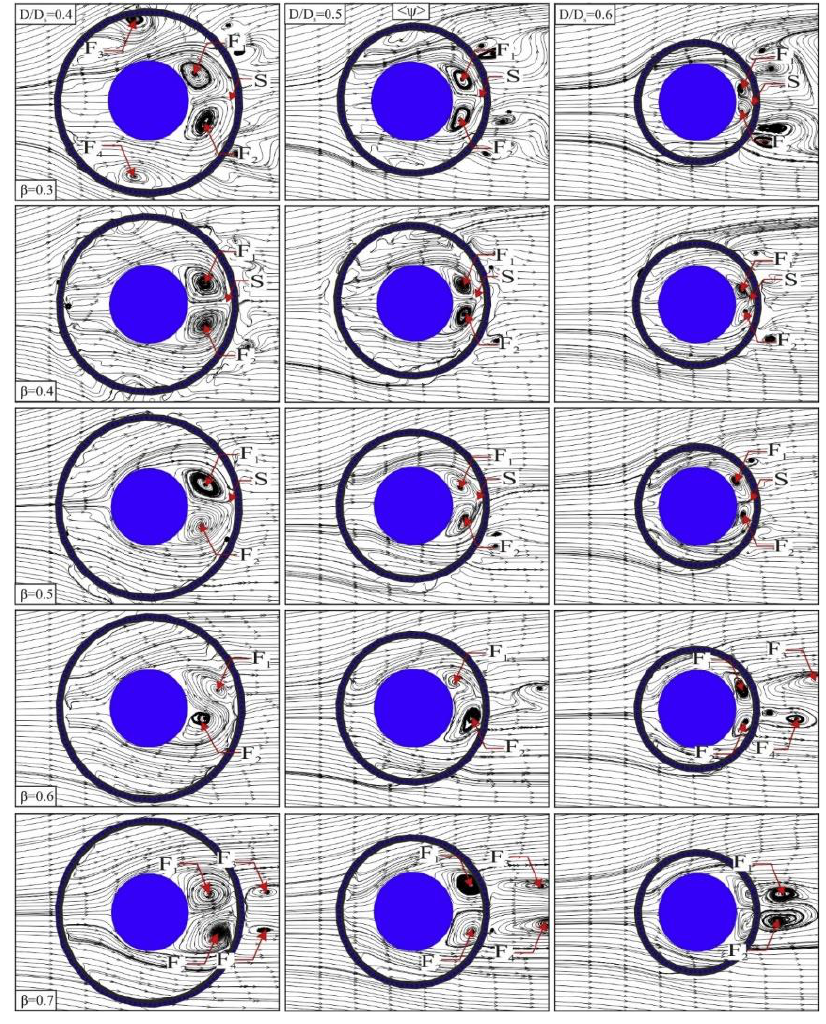
Figure 3. Time-averaged streamline topology for various porosities at different diameter ratios D/Ds = 0.4, 0.5 and 0.6; figure reprinted from Durhasan and Pinar [29] Copyright (2019), with permission from Elsevier. Table 2. Studies on flow control and suppression of vortex shedding by employing a permeable wall on bluff bodies. Researchers